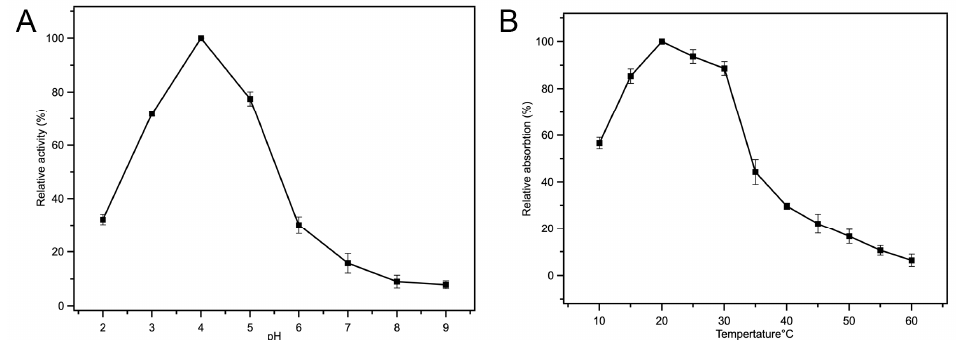
Figure 3. E ff ect of pH and temperature on Fe-loaded MOF-545(Fe). ( A ) The relative activity of the Fe-loaded MOF-545(Fe) in di ff erent pH, ( B ) the peroxidase-like activity of the Fe-loaded MOF-545(Fe) in di ff erent temperature.